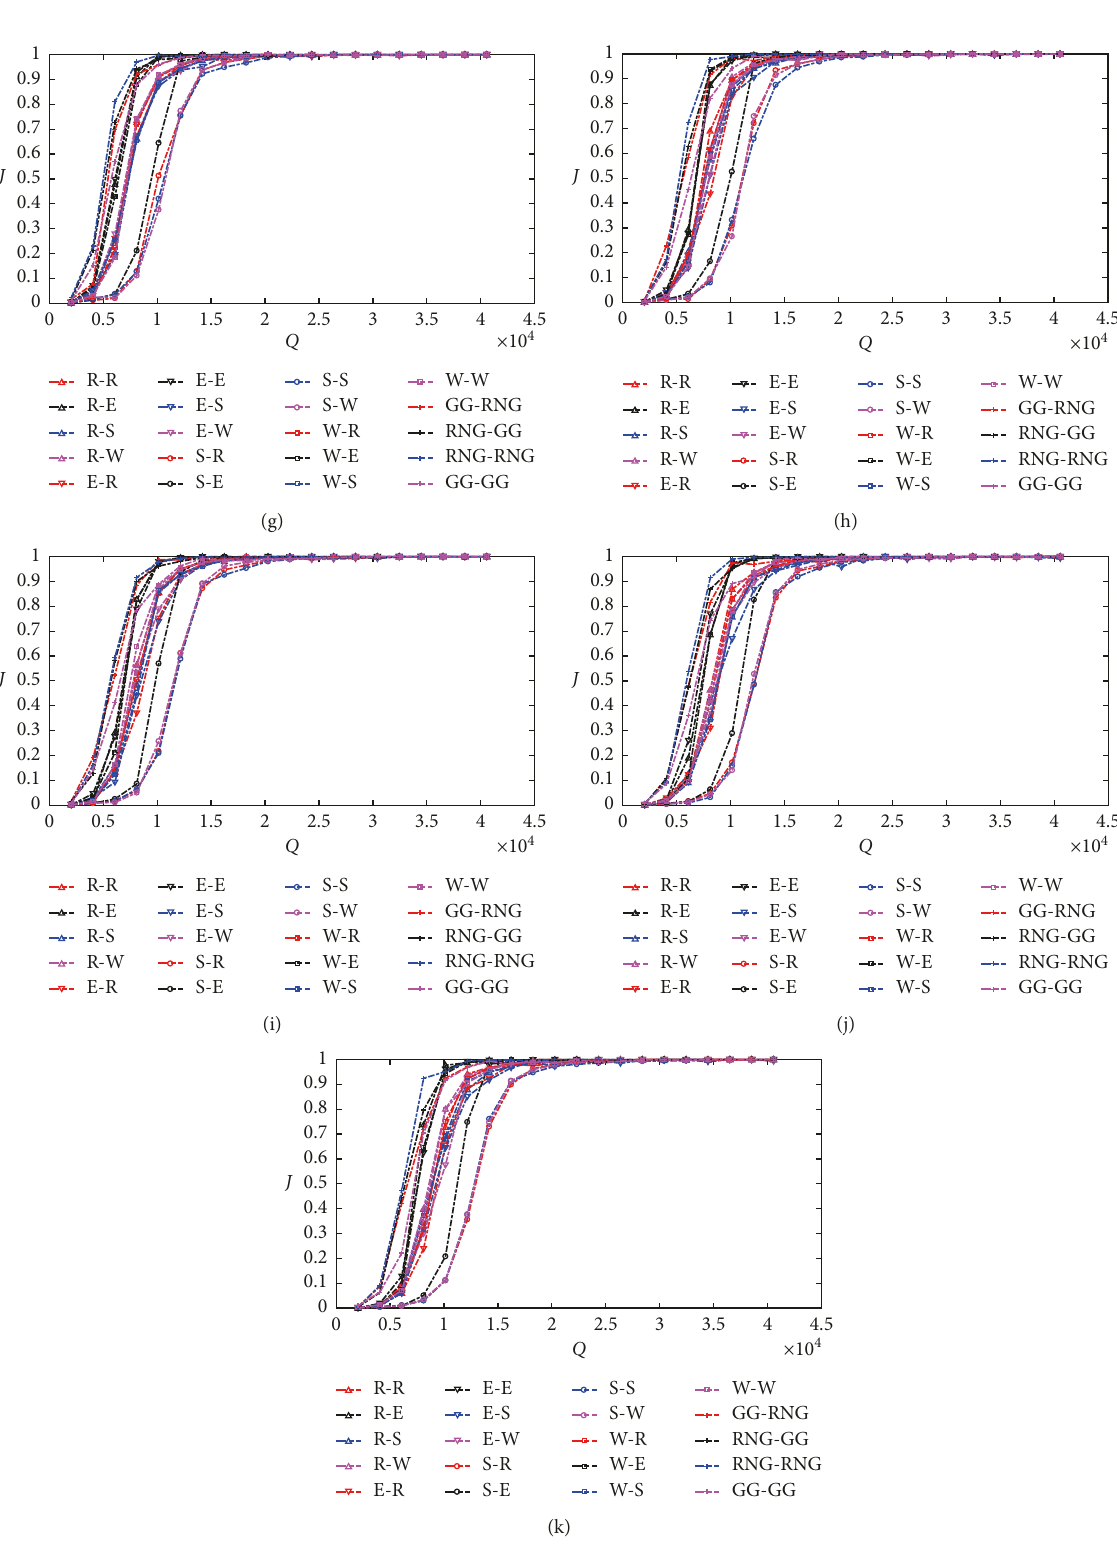
Figure 13: The influence of tunable parameter τ on multilayer networks (with different numbers of nodes) when the networks are randomly connected. (a) τ � 1. (b) τ � 1 . 1. (c) τ � 1 . 2. (d) τ � 1 . 3. (e) τ � 1 . 4. (f) τ � 1 . 5. (g) τ � 1 . 6. (h) τ � 1 . 7. (i) τ � 1 . 8. (j) τ � 1 . 9. (k) τ �